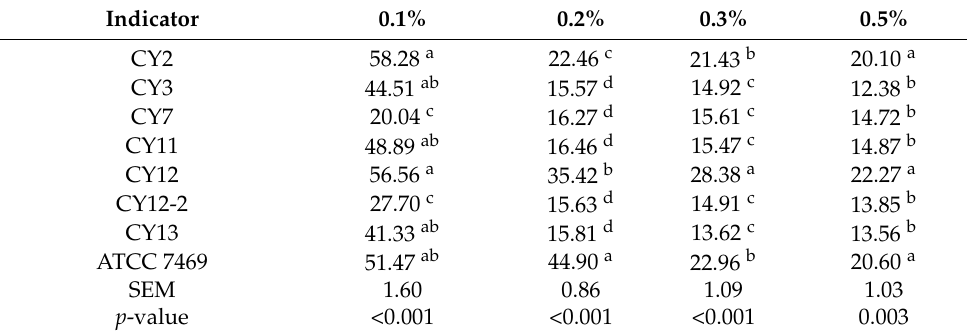
Table 3. Effect of bile salt on viability of Lactobacillus .